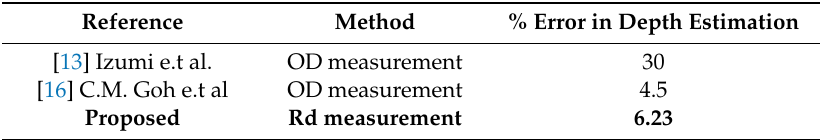
Table 2. Comparison table.